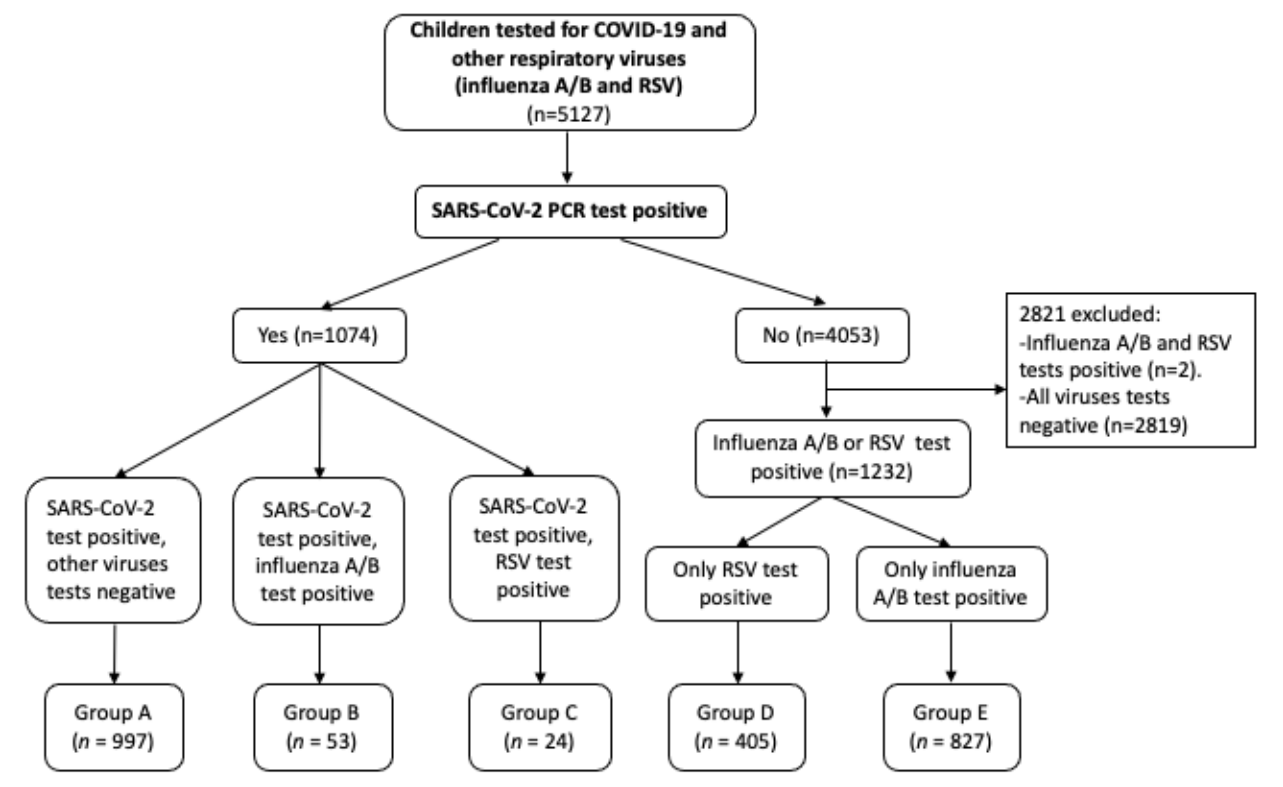
Figure 1. Stratification of enrolled patients. COVID-19—coronavirus disease 2019, PCR—polymerase chain reaction, RSV—respiratory syncytial virus, SARS-CoV-2—severe acute respiratory syndrome coronavirus 2.